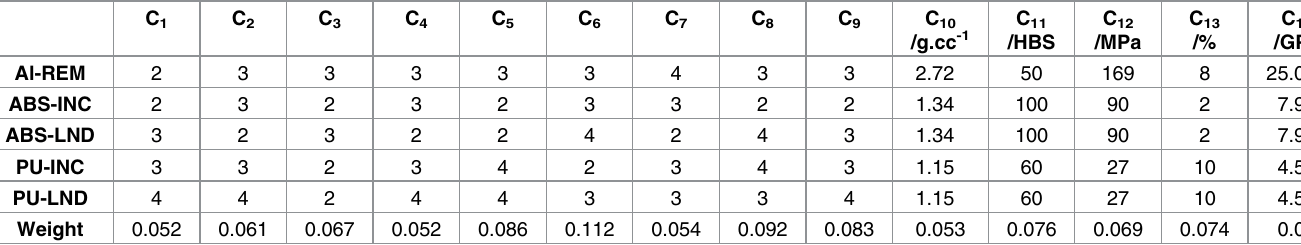
Table 7. A decision matrix for five material